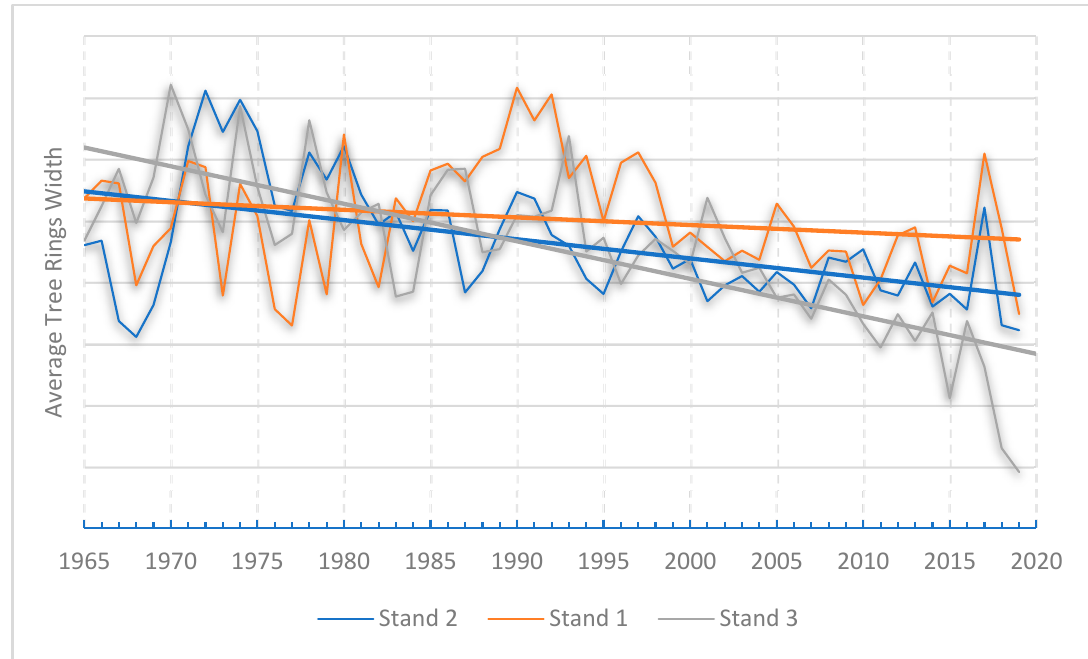
Figure 2. Master Average Tree Rings Width indices for stands 1, 2, 3 against time.